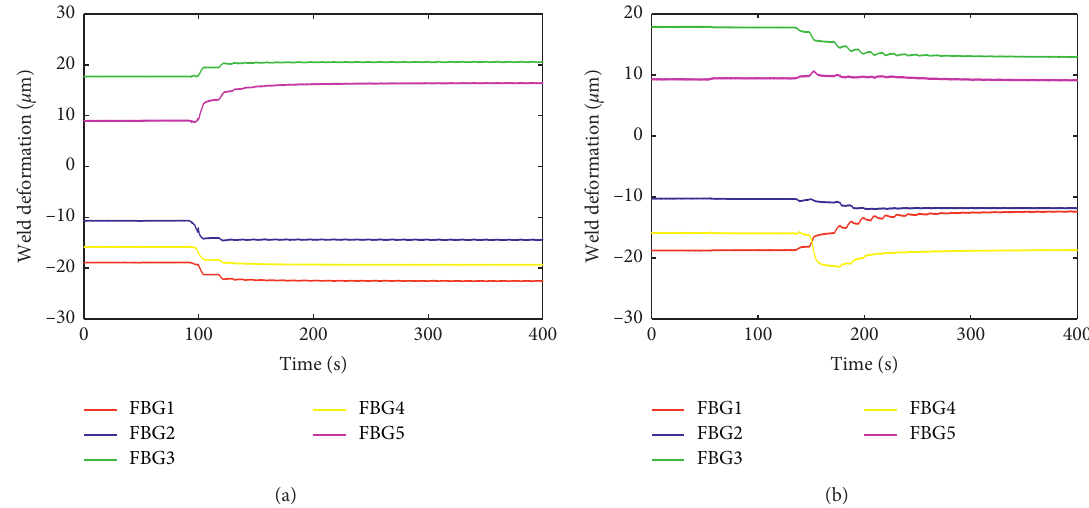
Figure 7: Welding deformation of eccentric loading of the top beam at a high position. (a) The block on the left side. (b) The block on the right